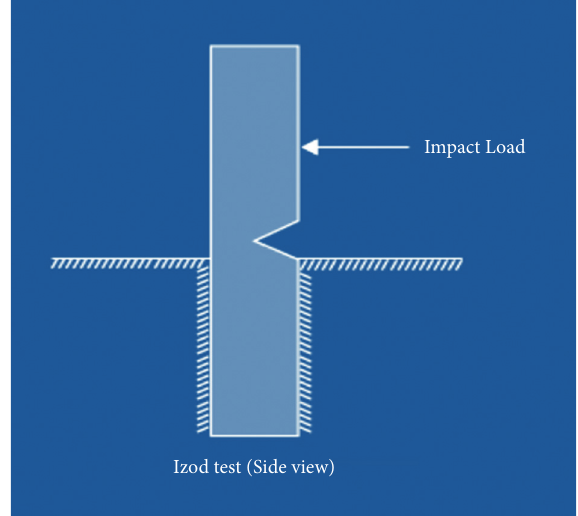
Figure 4: Impact test specimen position.